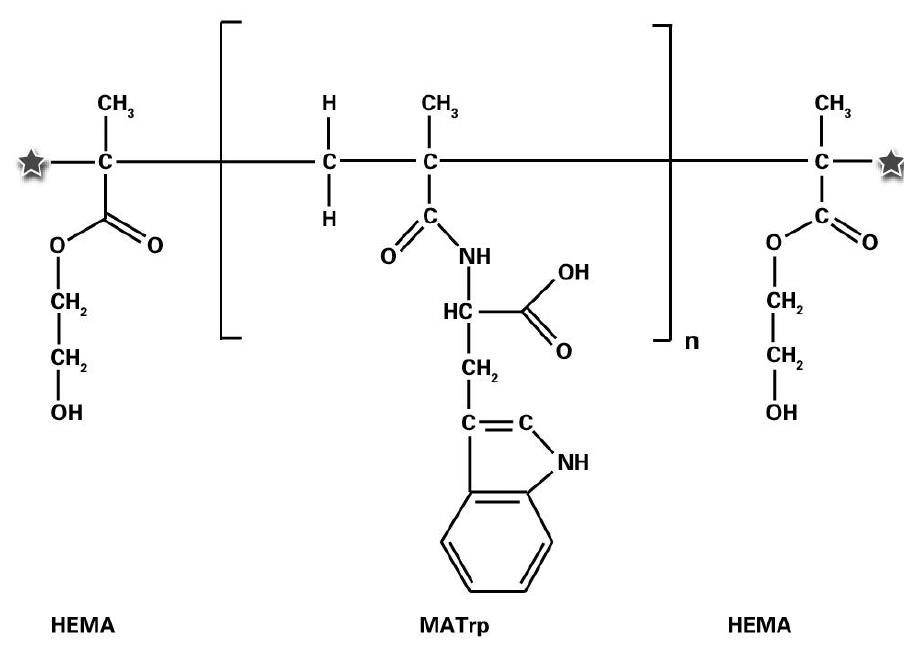
Figure 2. Schematic representation of PHEMATrp polymeric film.